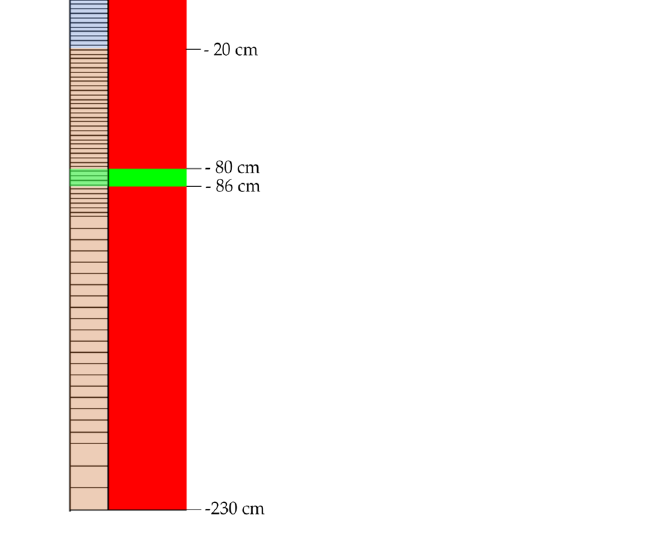
Figure 6. Soil profile discretization adopted in HYDRUS-1D. The blue, green, and brown colors indicate the first, impervious, and second layers, respectively. Table 3. Statistical indicators comparing the performance of the five approaches in order to describe the measured soil water